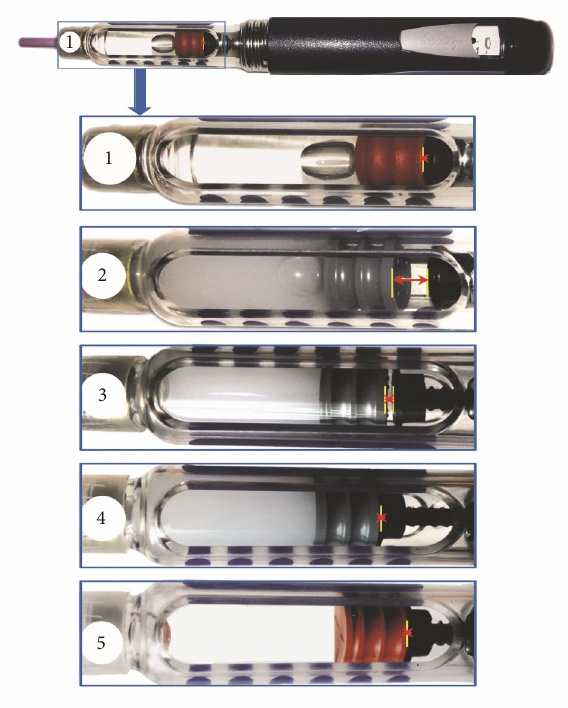
Figure 1: Illustration of insulin delivery during faulty injection technique. Numbers 1–5 demonstrate each of the highlighted steps of the delivery. The cartridge plungers in red and grey are basal and premix (30/70) insulin, respectively. In steps 2 and 3, two yellow lines represent the gap between screw (black) and cartridge plunger (grey) during delivery while a single yellow line represents no gap (steps 1 and 4-5). Details of the figure have been mentioned in the